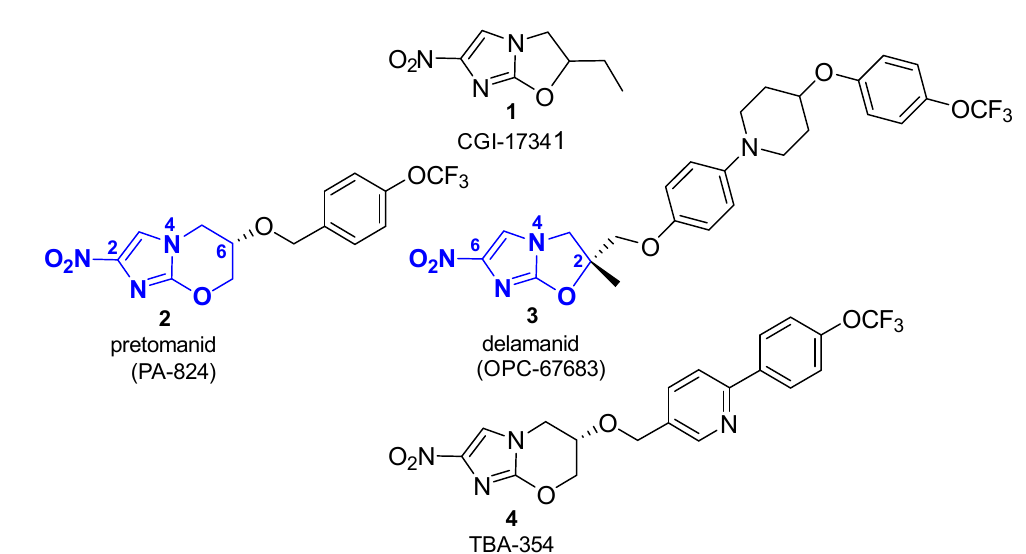
Figure 1. Original bicyclic imidazole lead ( 1 ), approved ( 2 , 3 ) and Phase I ( 4 ) drugs.